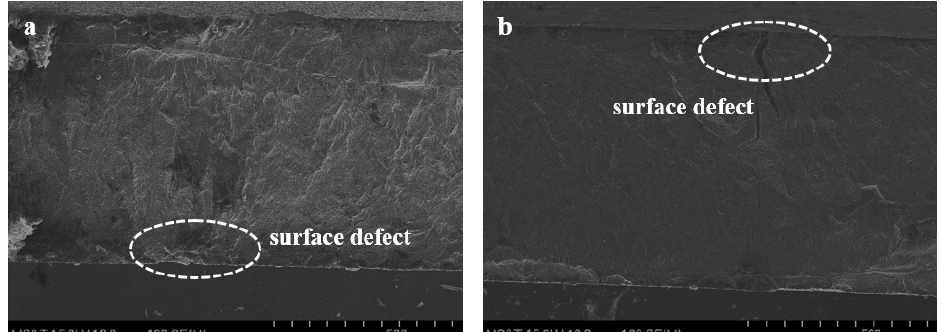
Figure 12. SEM images of the fracture surfaces with possible crack initiation sites (marked by white dashed circles) of the specimens fabricated by the optimized parameters; ( a ): horizontal orientation; ( b ): inclined